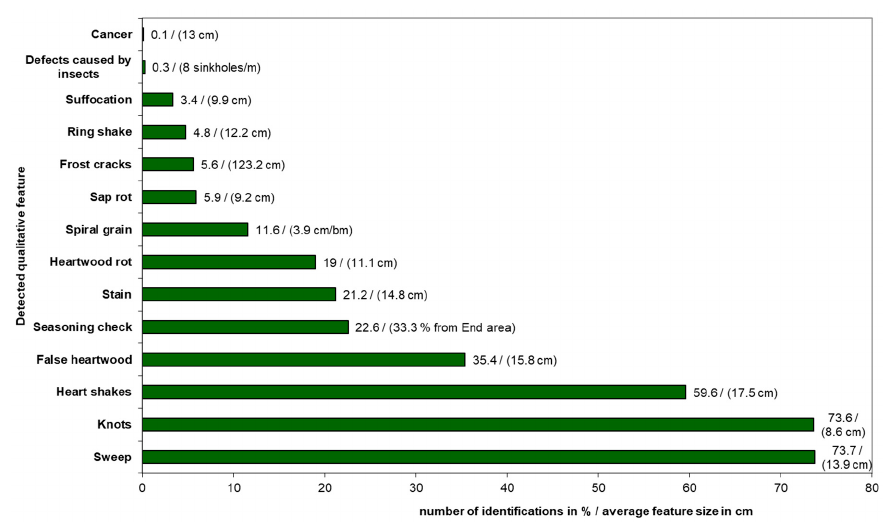
Figure 1. Percentage occurrence of recorded qualitative features and their average size in the entire sample of non-coniferous trees.